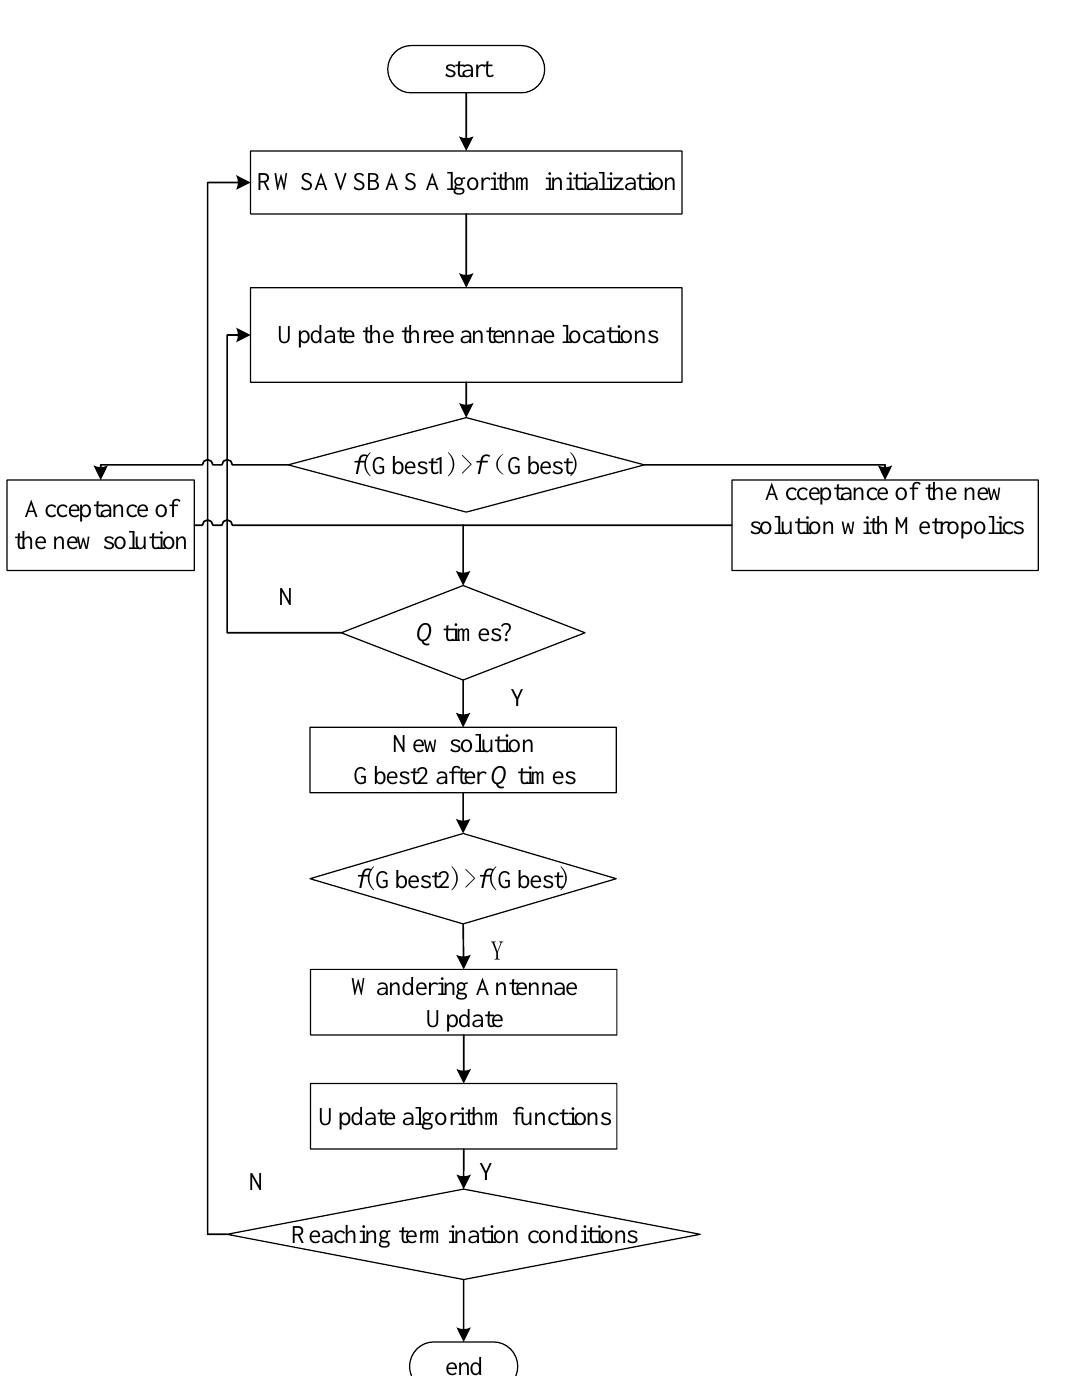
Figure 5. RWSAVSBAS algorithm